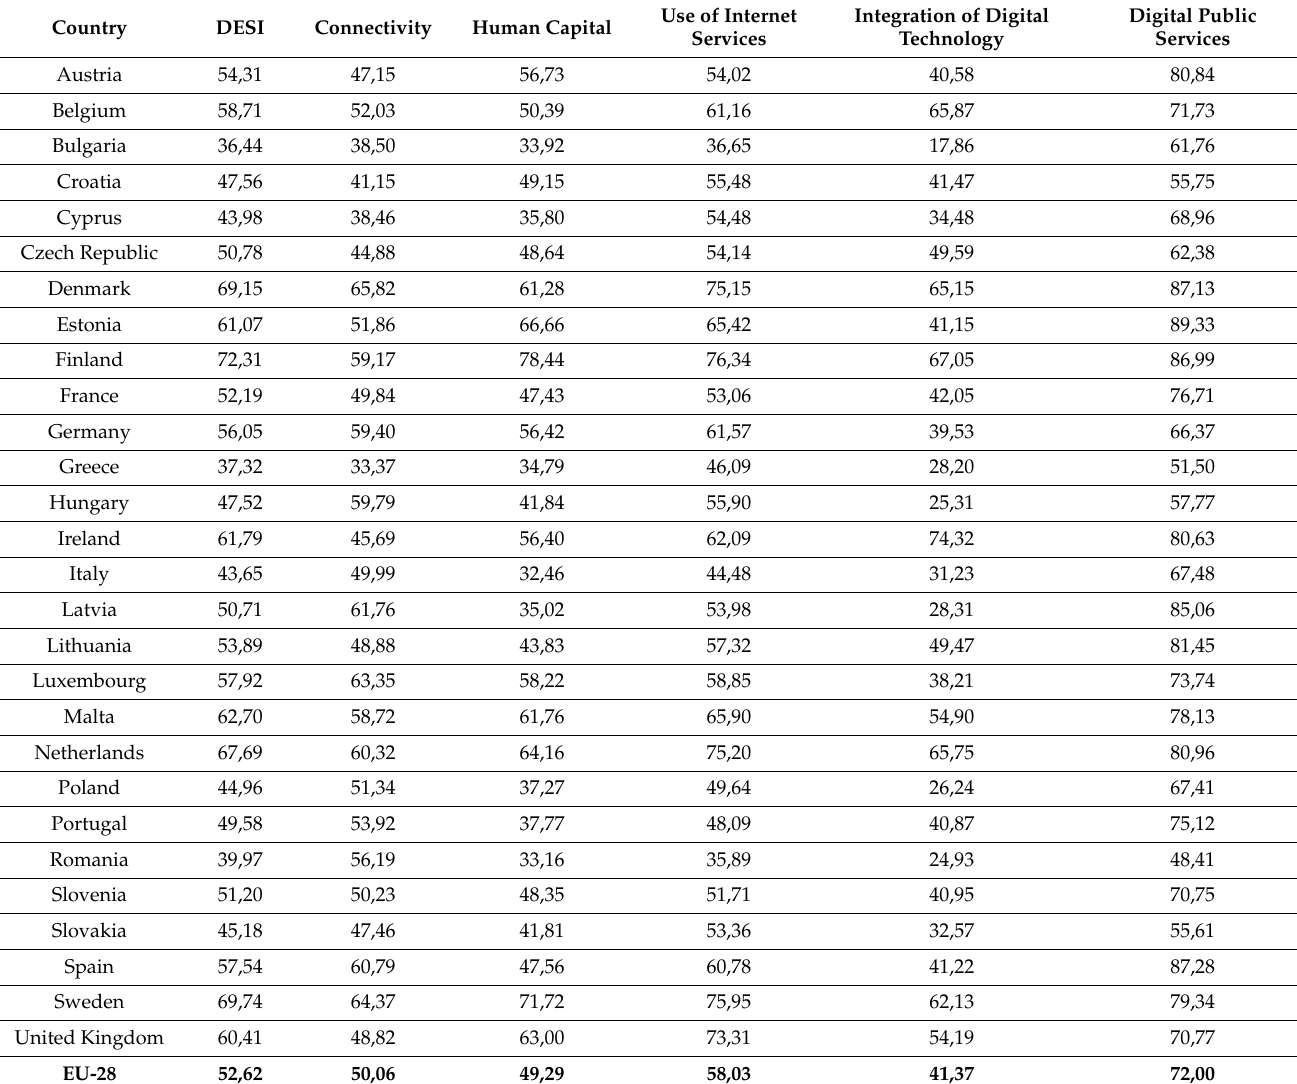
Table A2. DESI and its subcomponents in 2020 in a cross-section of EU-28 countries *. Country DESI Connectivity Human Capital